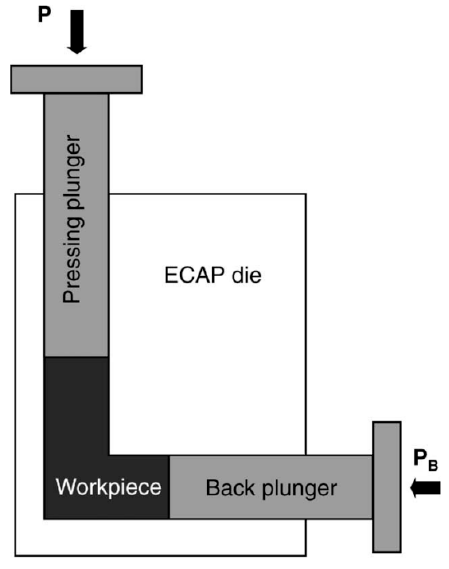
Figure 19. The BP-ECAC/BP-ECAD set-up.